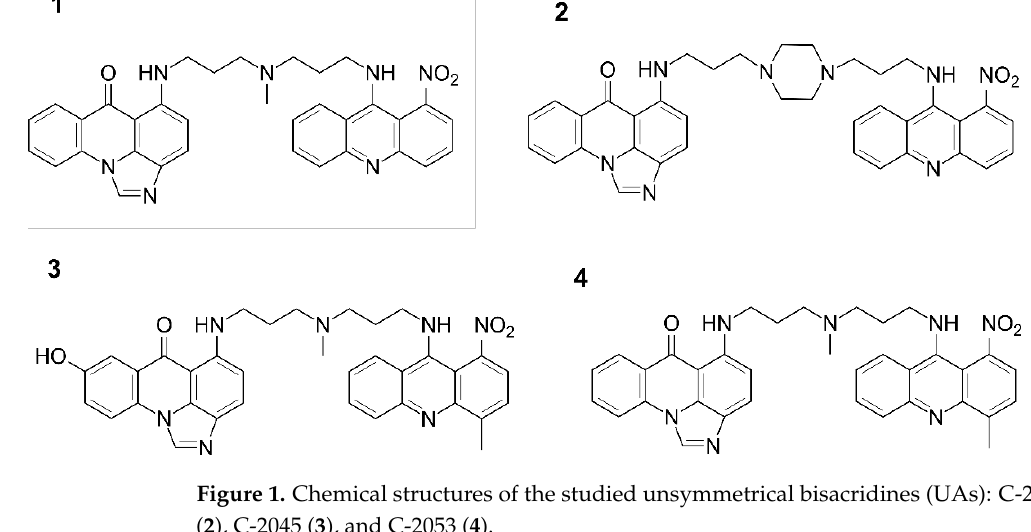
Figure 1. Chemical structures of the studied unsymmetrical bisacridines (UAs): C-2028 ( 1 ), C-2041 ( 2 ), C-2045 ( 3 ), and C-2053 ( 4 ).